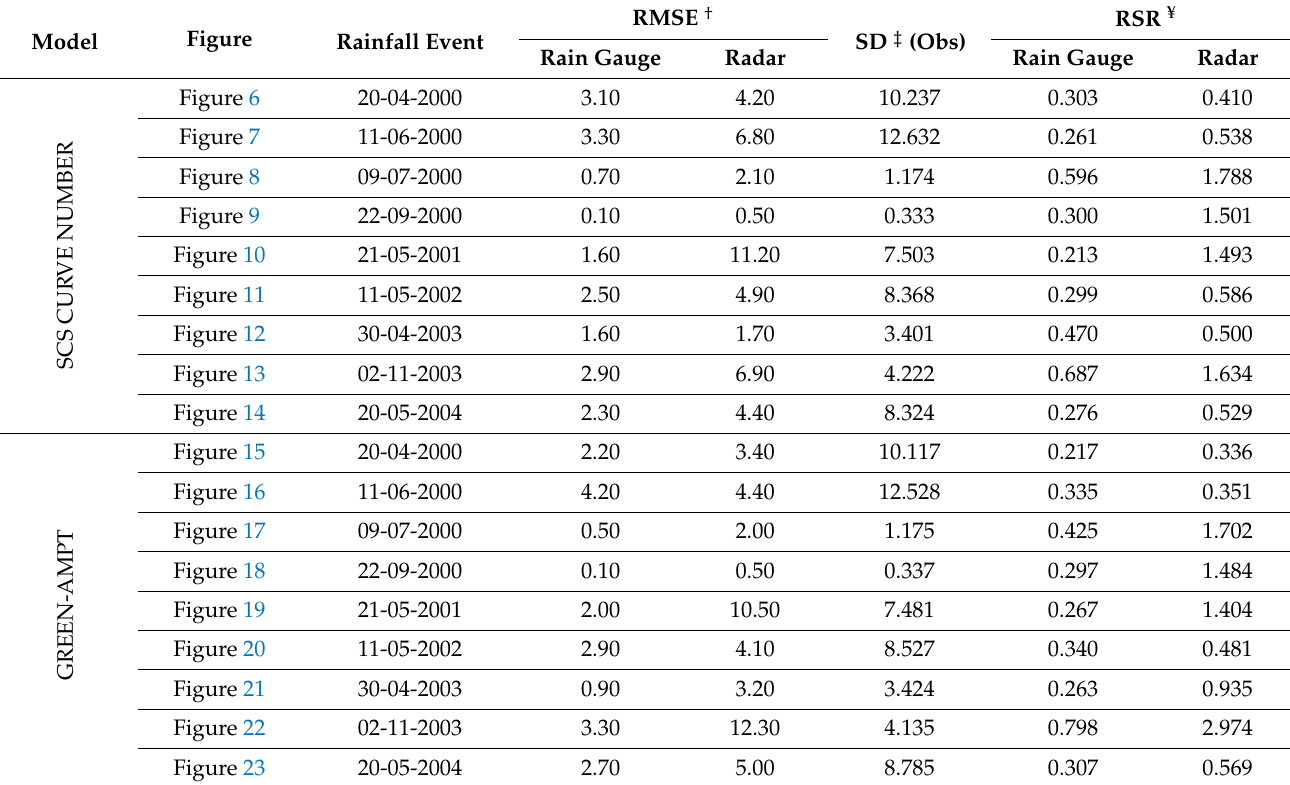
Table 15 adds a more statistical explanation to the analysis by using RMSE, SD, and RSR for streamflow using the SCS curve number method and Green and Ampt method using different rainfall inputs. It is obvious from the RMSE values for rain gauge